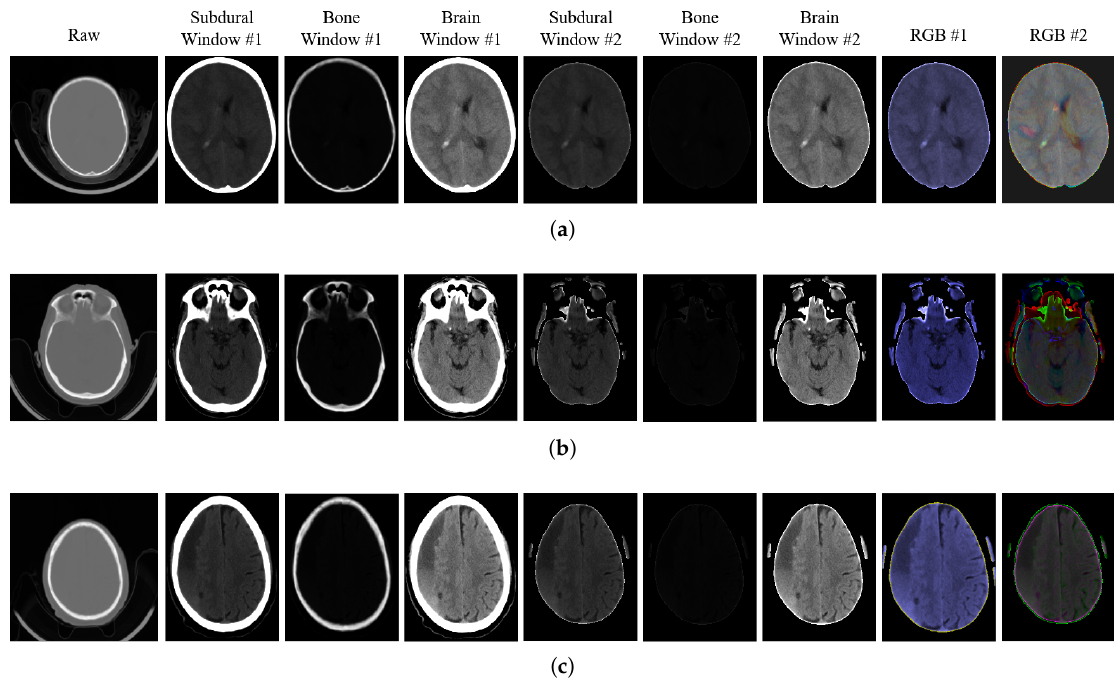
Figure 3. Illustration of the results of subsequent preprocessing stages in three sample CT slices ( a – c ). Columns (left to right): raw CT slice before region of interest (ROI) extraction, subdural-window image, brain-window image, bone-window image (first three before and next three after skull removal), a stack of three CT-windowed images (Branch #1), a stack of three neighboring slices (Branch